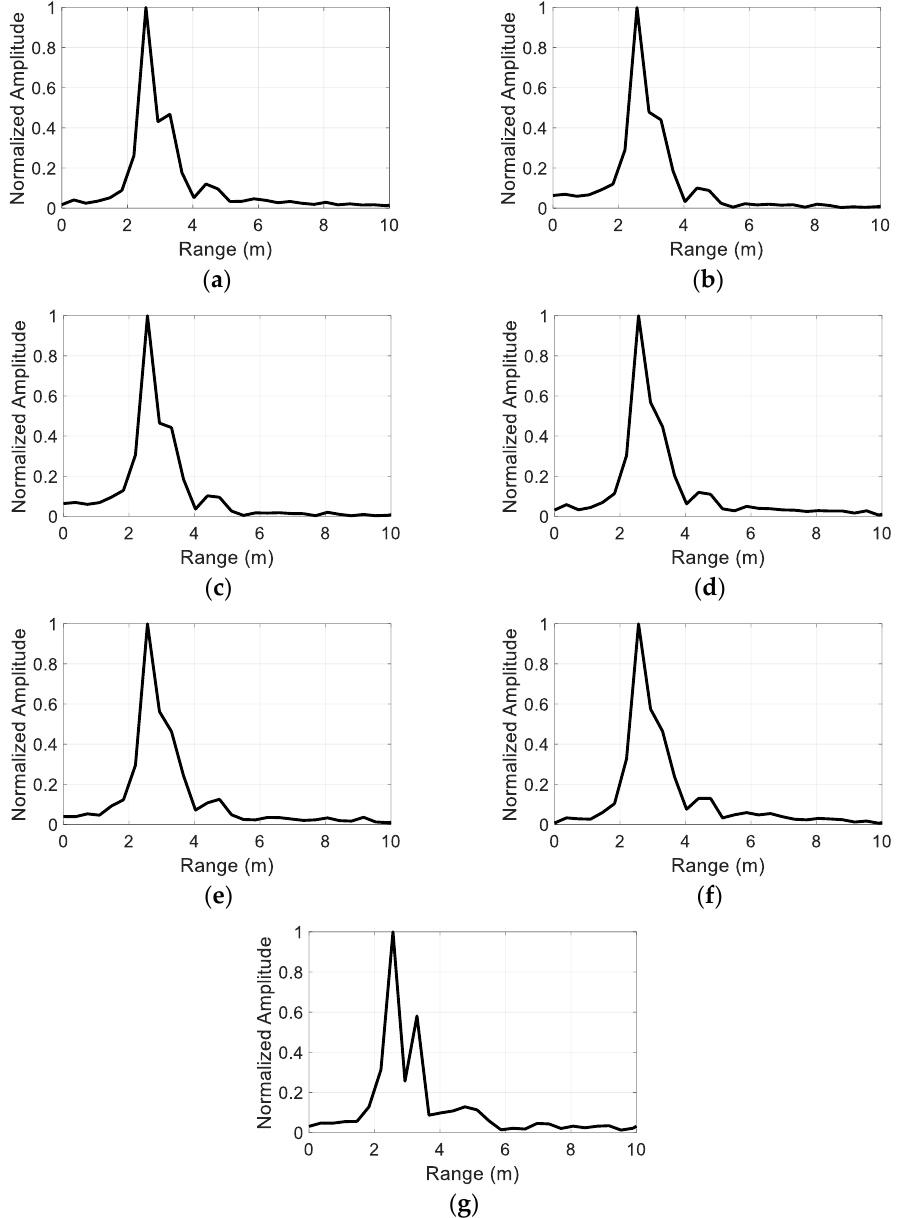
Figure 11. Compressed target echo as a function of the range for each measured target. ( a ) laptop, ( b ) tablet PC 2, ( c ) tablet PC 1, ( d ) diode-terminated antenna, ( e ) cell phone, ( f ) radio 2, ( g ) radio 1. Range accuracy can be improved by considering the beat frequency error [27], which refers to the difference between the ideal beat frequency and the measured beat